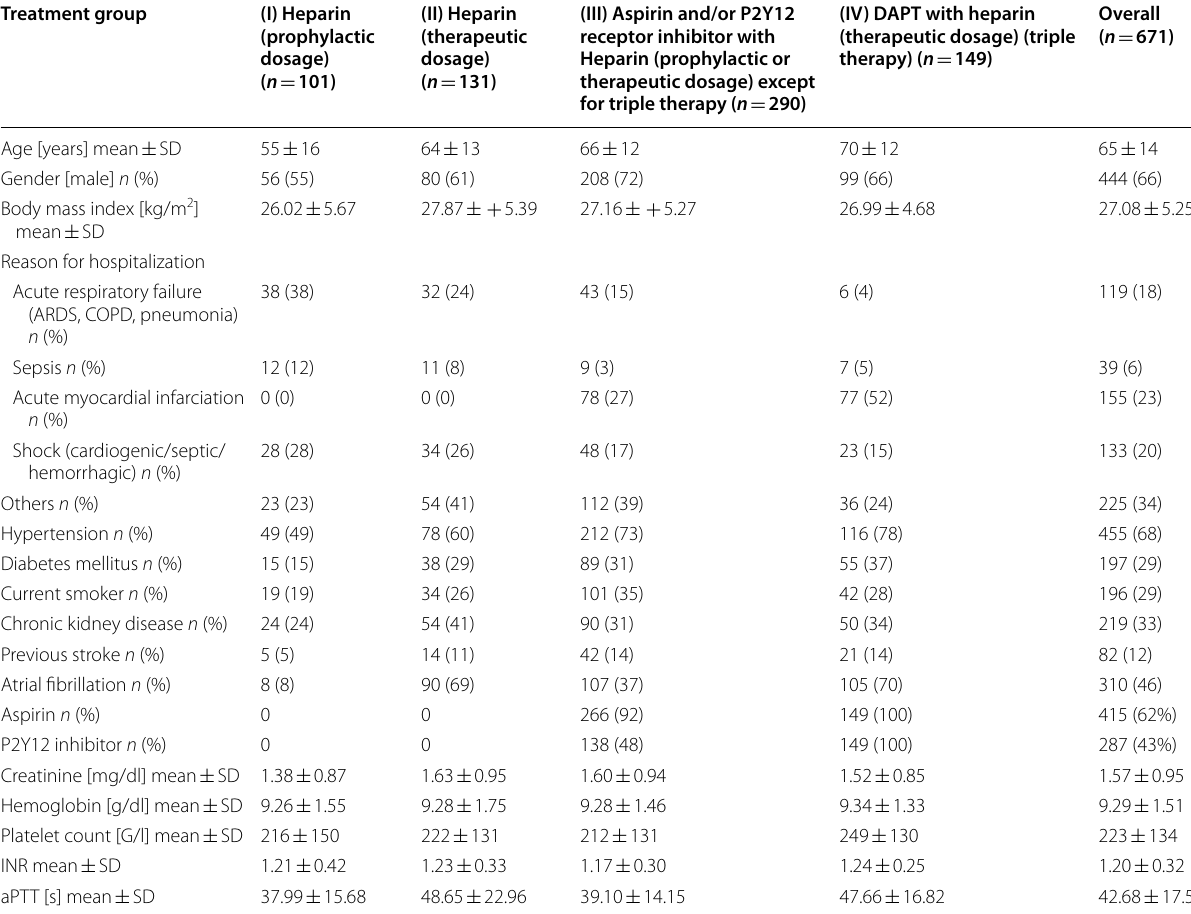
Table 1 Baseline characteristics of different antithrombotic treatment groups with a total of 671 patients included between January 2016 and October 2019 at ICUs of 12 clinical sites: (1) intravenous unfractionated heparin (iUFH, prophylactic dosage), (2) iUFH (therapeutic dosage), (3) antiplatelet therapy (aspirin (100 mg/day) and/or P2Y12 receptor inhibitor, i.e. clopidogrel (75 mg/day), prasugrel (10 mg/day) or ticagrelor (90 mg twice daily)) with iUFH (prophylactic or therapeutic dosage) except for triple therapy